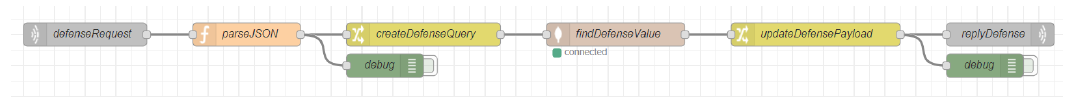
Figure 6. Second part of the defence flow: processing a request message.